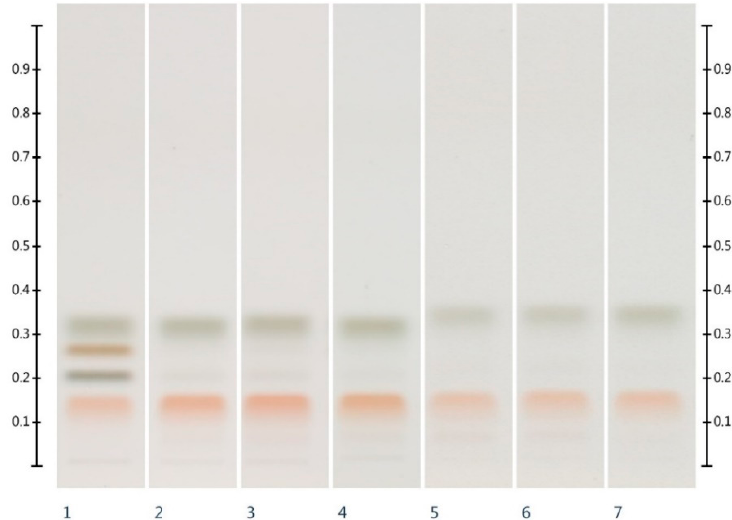
Figure 1. HPTLC images taken at T White light after derivatisation with aniline-diphenylamine- phosphoric acid reagent; Track 1—Standards (fructose, maltose, sucrose and glucose in increasing Rf values), Track 2—MAN, Track 3—JAR, Track 4—MAR, Track 5—KAR, Track 6—PEP, Track 7—WHG; Tracks 2–4 were obtained with 3 µL of aqueous methanolic honey solution, while Tracks 5–7 were obtained with 2 µL of aqueous methanolic honey solution.